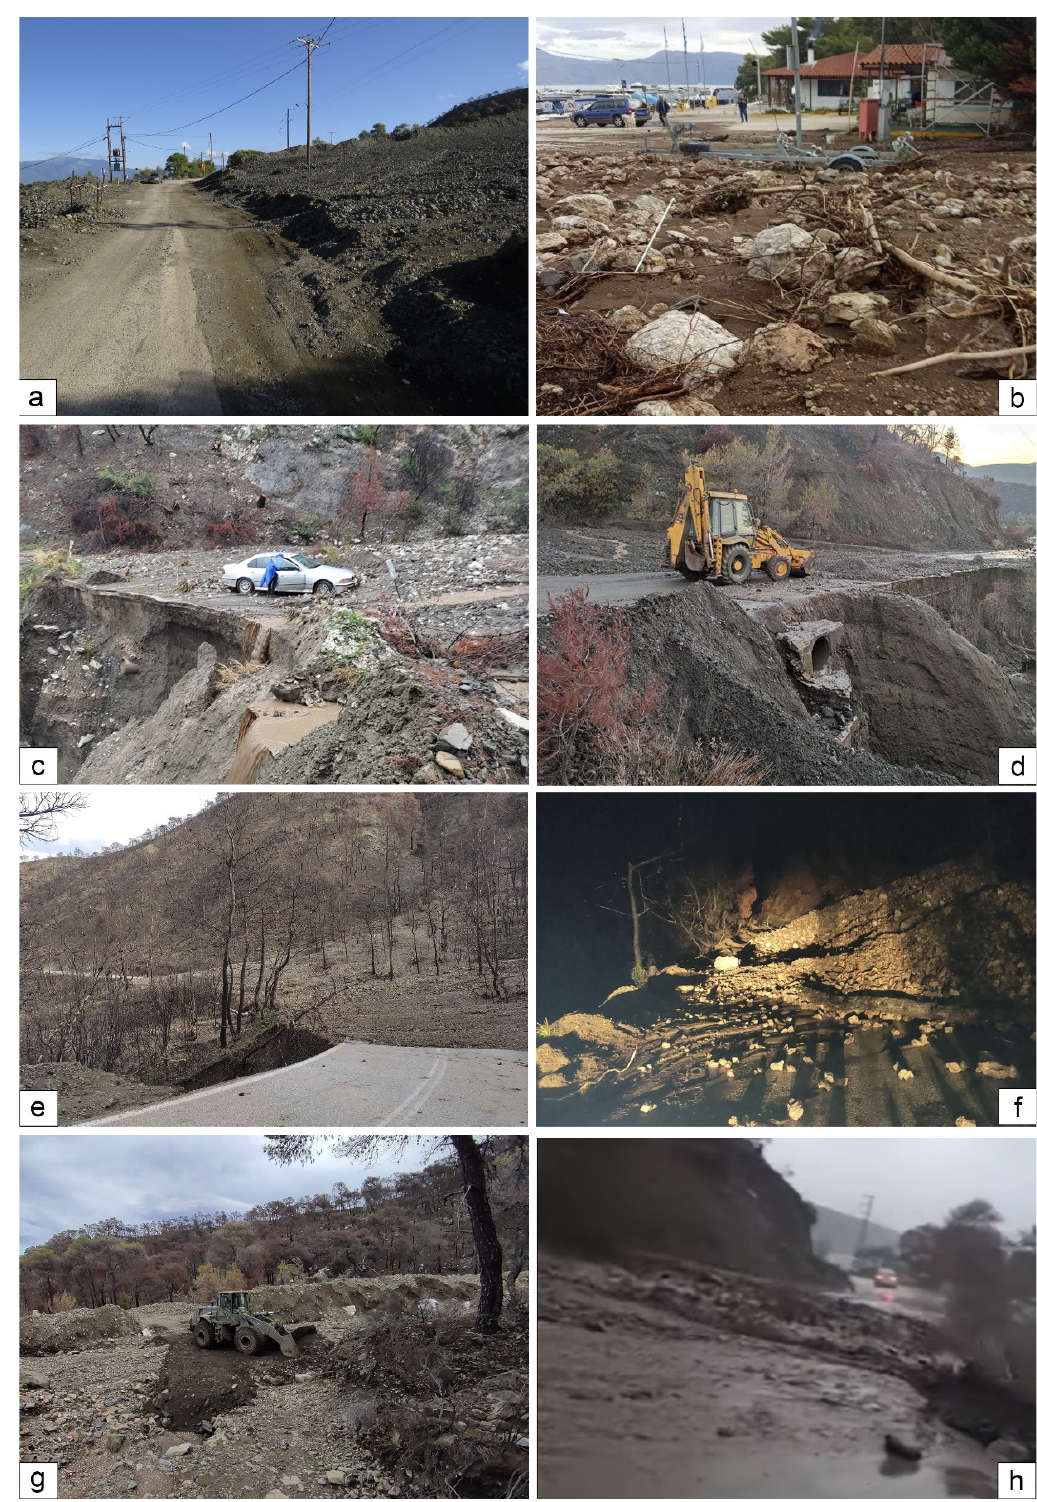
Figure 6. Debris flow occurrence in multiple locations across the study area, namely: ( a ) along the road from Vamvakies to Schinos, in the southwest edge of Vamvakies settlement (outlet of basin B7), ( b ) in Mavrolimni small port (near the outlets of basins B12 and B13), ( c ) along the road between Schinos and Vamvakies at the outlet of basin B6, ( d , h ) at the outlet of basin B5, and ( e ) at the outlet of basin B8, ( f ) along the road from Mavrolimni to Alepochori at the outlet of basin B14, and ( g ) at the outlet of basin B15.